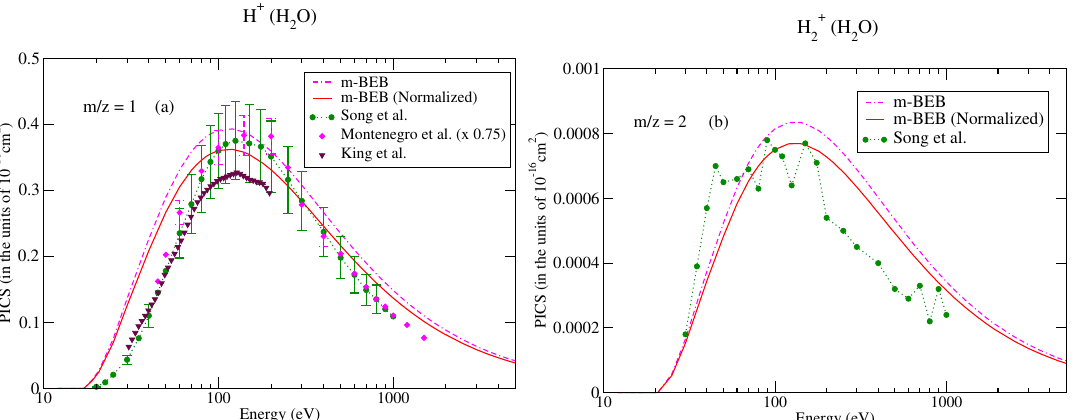
Figure 6. Partial ionization cross-sections for different fragments of water: ( a ) m / z = 1, ( b ) m / z = 2. dashed dotted curve, m-BEB; line curve, normalized m-BEB; dots with circles, recommended data of Song et al. [74]; inverted triangles, King et al. [76]; diamonds, scaled cross-sections of Montenegro et al.